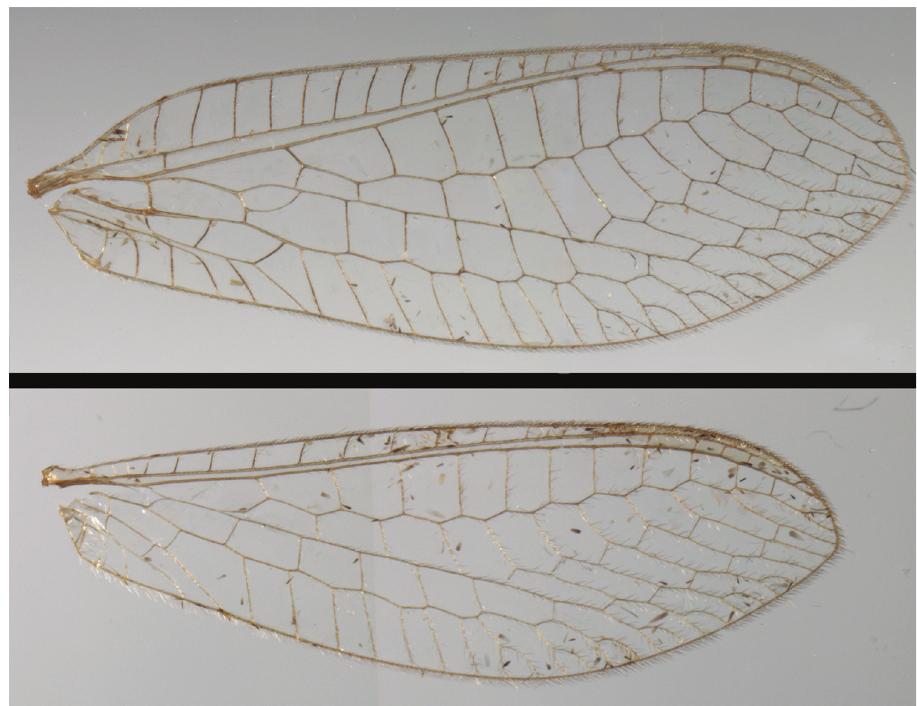
Figure 39. Ungla favrei (Navás): Wings (Bolivia, Cochabamba, female, CAS). gin extending forward toward base of mediuncus, as short, ledge-like protuberance; lateral margins of the gonarcal apodemes with short, rounded lateral process extend- ing forward. Mediuncus broad, thick basally (at attachment to the gonarcal bridge), becoming narrow distally, length ~1.8× height of gonarcus (measured in lateral view), distal portion arching downward from base, terminus with slightly enlarged